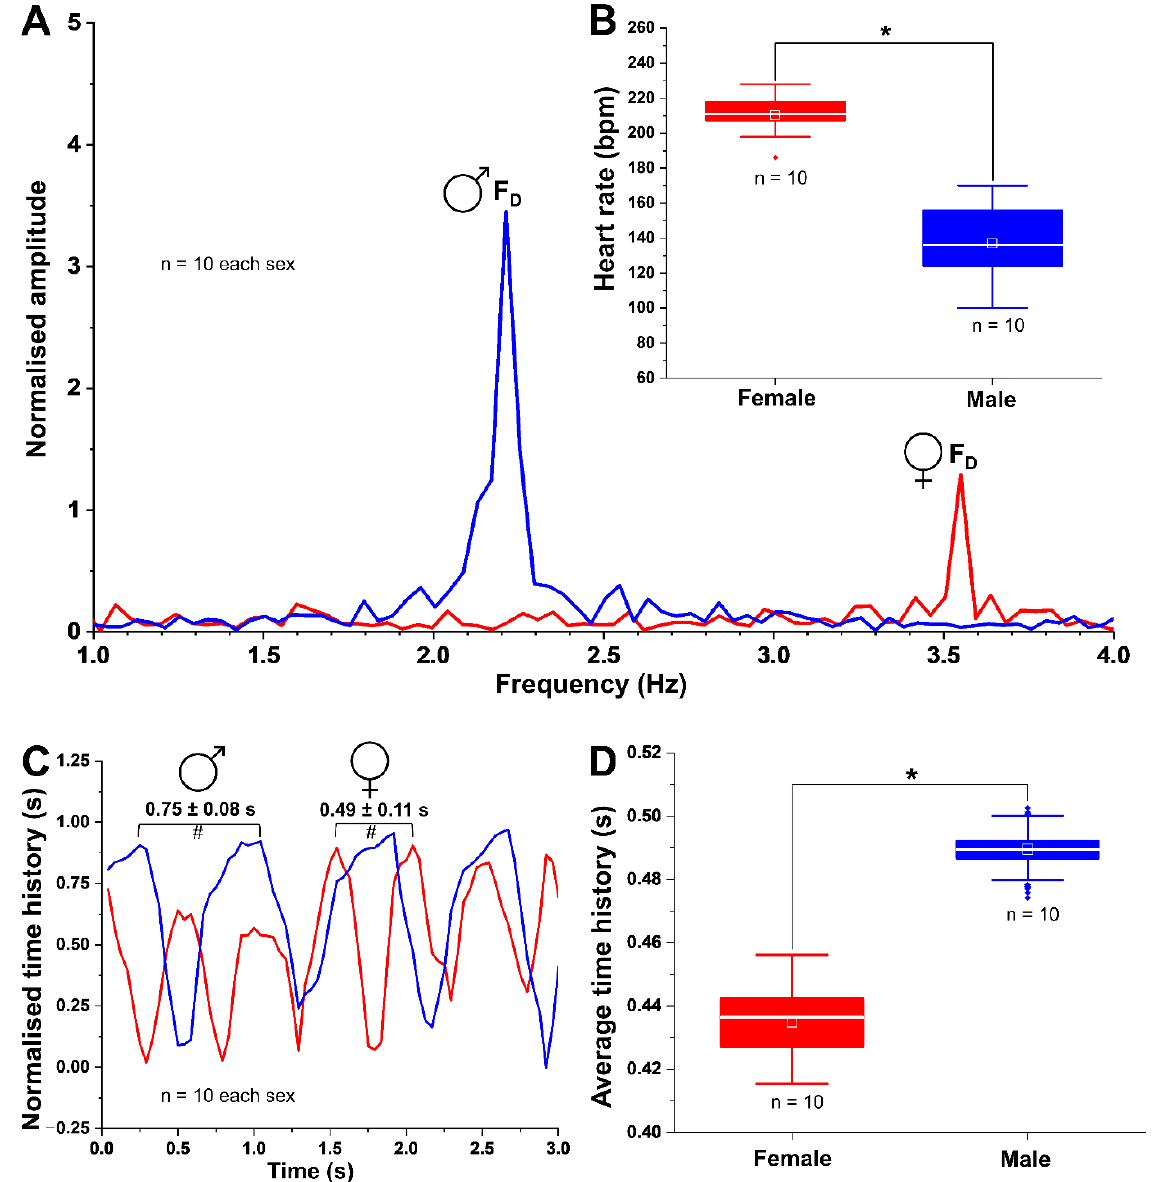
Figure 11. Graphs representing the sex-specific differences in average F D ( A ), HR (( B ) inset), cardiac cycle period ( C ), and time history between ventricular contraction ( D ) in adult males and females of G. holbrooki . ( C ) the cardiac cycle period, i.e., the time interval between two consecutive ventricular peaks, is marked with # for both sexes. Box plot data are presented as means ± SD (n = 10/sex). Values with an asterisk are significant (* p < 0.05). Small square and a horizontal line on each box plot are shown mean and median values, respectively.